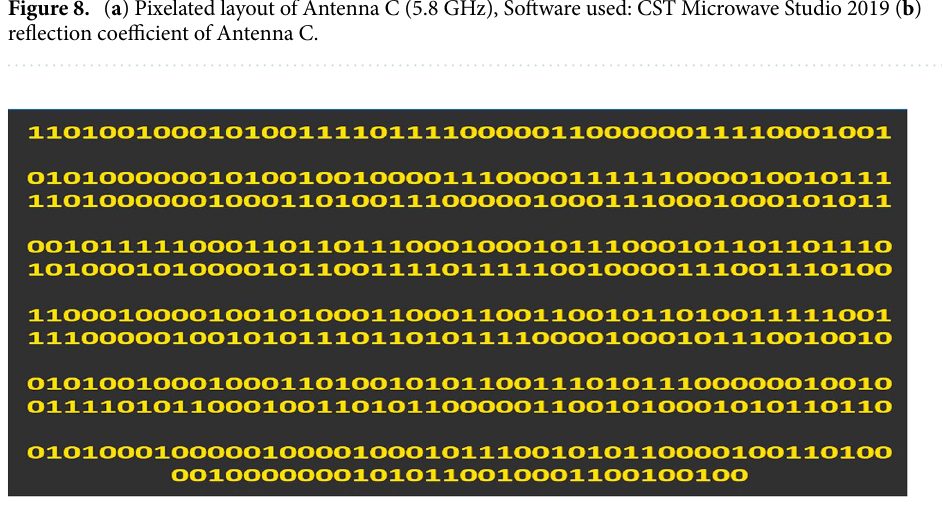
Figure 9. Optimal bit values for pixel